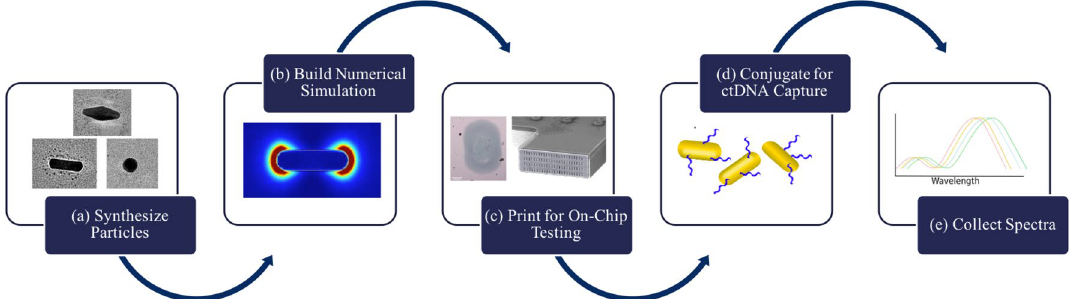
Figure 1. Overall study workflow . In this paper, the effects of nanoparticle geometry on plasmonic sensitivity are probed in the context of ctDNA liquid biopsy. First, ( a ) synthesis of gold nanoparticles and ( b ) development of numerical simulations with matching geometry. Then ( c ) dispersion of particles on-chip using microfluidic printing for ( d ) ctDNA capture and ( e ) comparison of the spectral sensing results to the simulation. This allows for an evaluation of the biosensing performance of the synthesized particles and how well it compares to